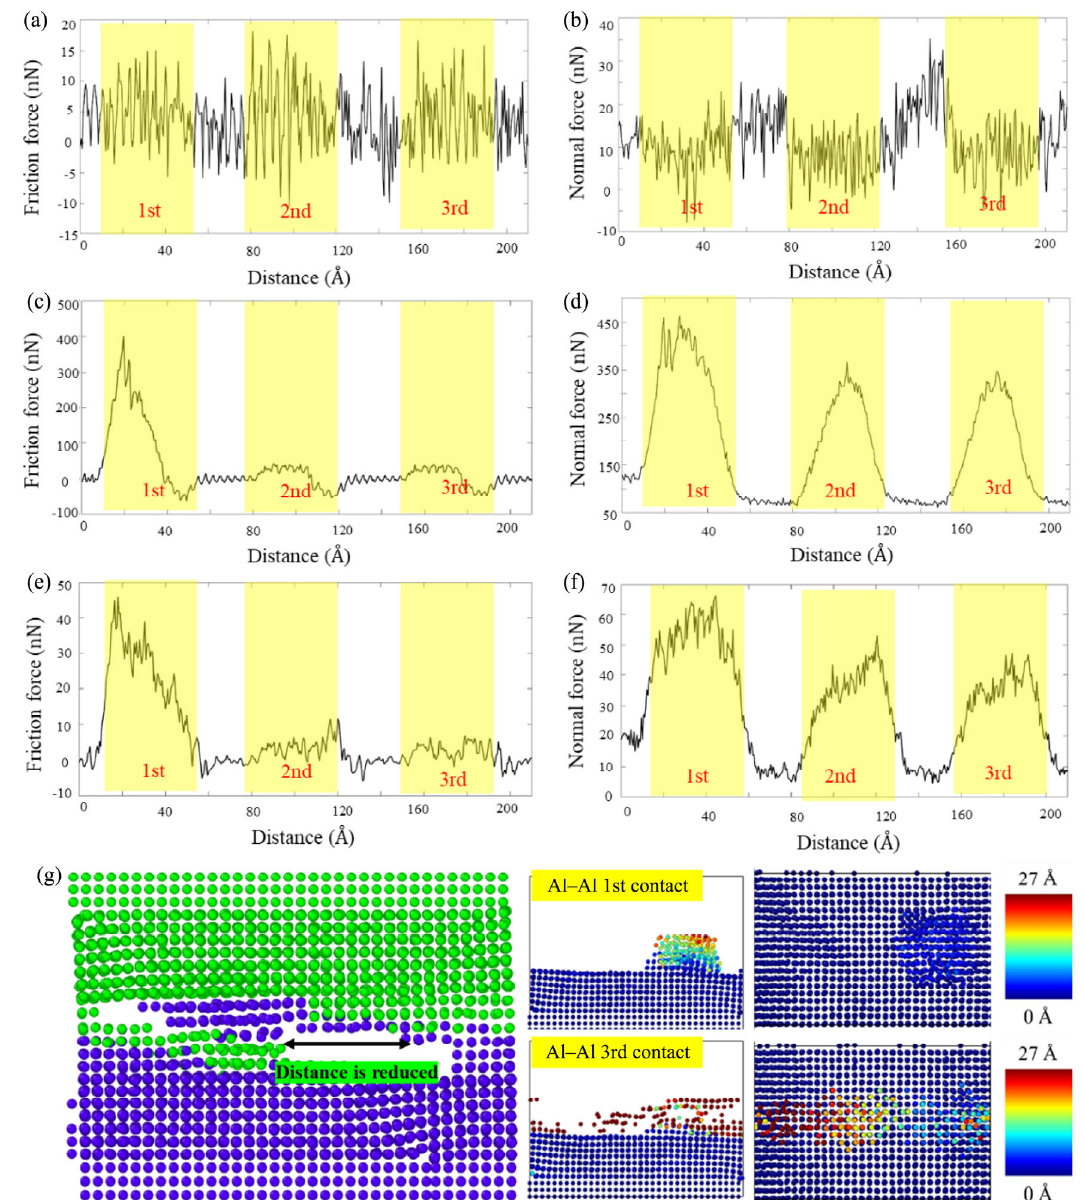
Fig. 6 Force responses between the fretting interfaces during continuous frictional contact: (a) the friction force responses for the Al–Al fretting interfaces, (b) the normal force responses to the friction force for the Al–Al fretting interfaces, (c) the friction force responses for the diamond–diamond fretting interfaces, (d) the normal force responses to the friction force for the diamond–diamond fretting interfaces, (e) the friction force responses for the diamond–Si fretting interfaces, and (f) the normal force responses to the friction force for the diamond–Si fretting interfaces. All non-shadowed areas indicate the friction contact intervals, (g) illustration for the distance reduction and area increment of the Al–Al frictional contact, interval force responses, and the displacement of the Al–Al lower layer. Table 2 Comparison of the simulated CoF and the CoF range. Material A Material B Friction coefficient range Simulated CoF Error Al